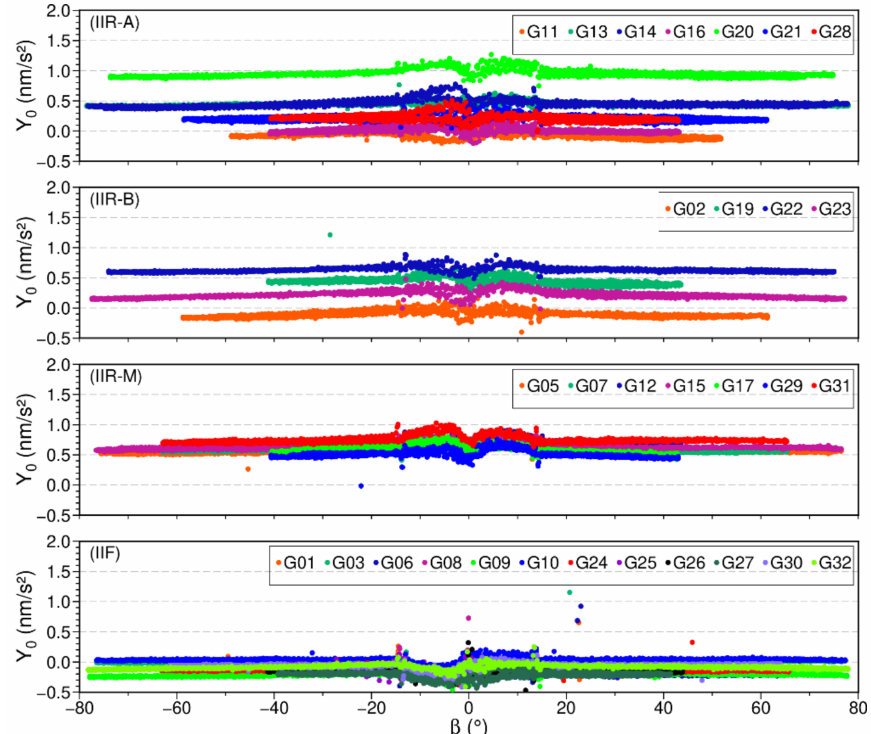
Figure 4. SRP coefficient Y 0 with respect to the β angle (the Sun elevation above the orbital plane) in the E1DYB solution from 2017 to 2019. From top to bottom: BLOCK IIR-A, BLOCK IIR-B, BLOCK IIR-M, and BLOCK IIF satellites,